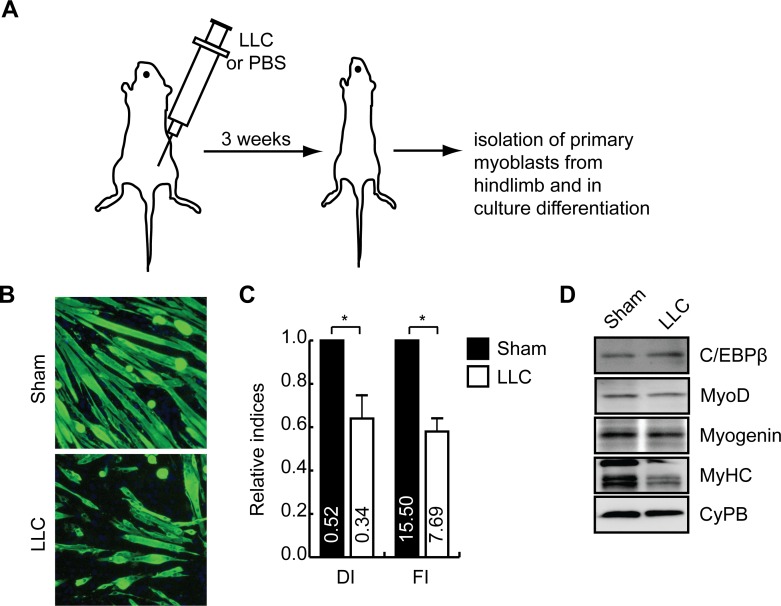
LLC tumor graft increases C/EBPβ expression in myoblasts and prevents myogenesis.
(A) 5x105 Lewis Lung Carcinoma (LLC) cells or PBS (Sham) was injected into the flank of C57BL/6 mice and allowed to engraft for 3 weeks to induce cachexia. (B) Immunocytochemistry for myosin heavy chain expression in primary myoblasts isolated from sham-injected and LLC-injected mice and differentiated for 2 days. (C) Differentiation (DI) and fusion (FI) indices from cultures isolated and differentiated as in (B). *p<0.05, n = 5. (D) Western analysis of C/EBPβ and myogenic marker expression in cells isolated from healthy or cachectic mice as in (A) and after culture expansion for 5 days, differentiated for 2 days. Cyclophilin B (CyPB) is a loading control.